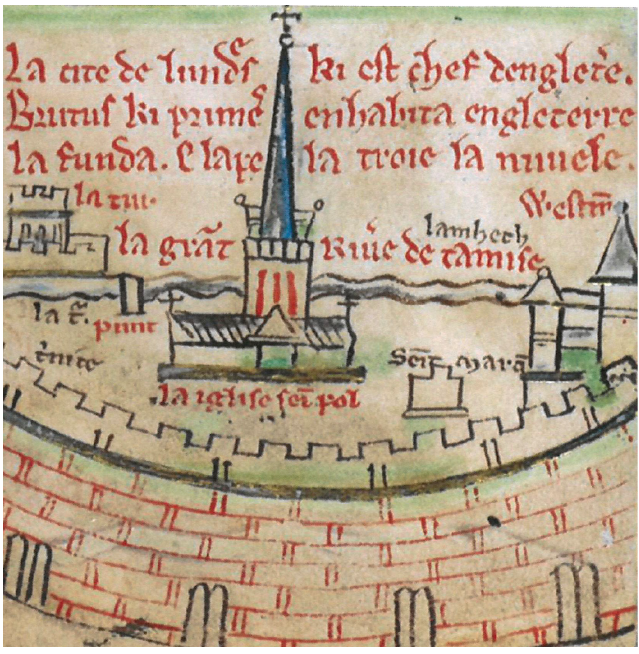
Fig. 6. Detail of London from itinerary (London to the Holy Land), by Matthew Paris, created c. 1252. London, British Library, Royal MS. 13 A. III, f.